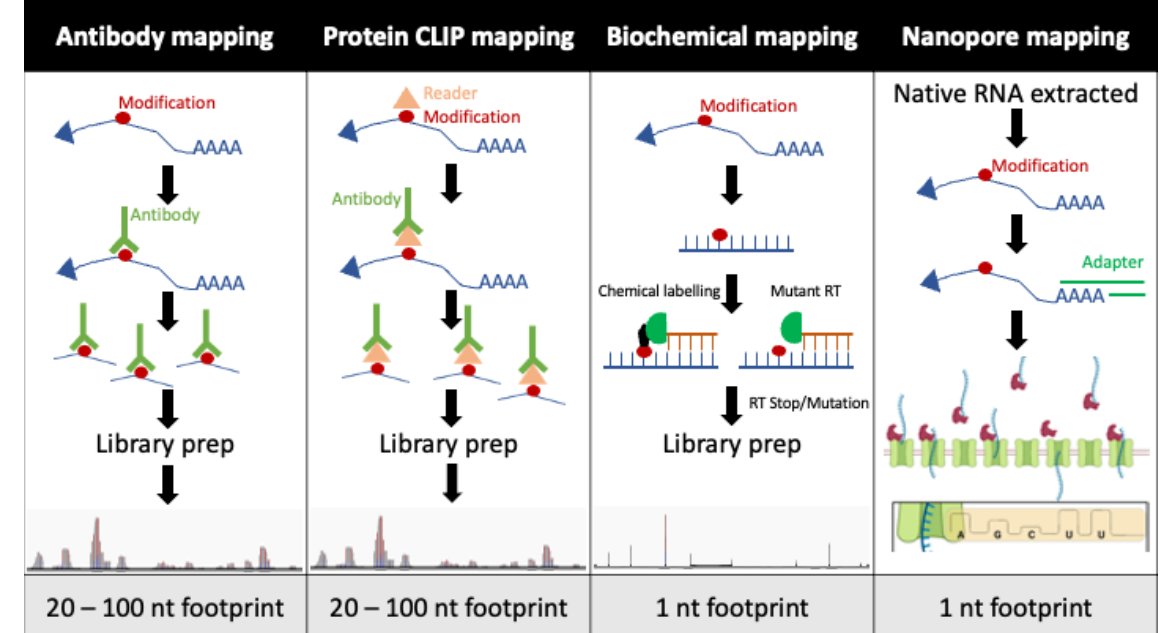
Figure 1. Schematic of the four main methods of mapping RNA modifications. Antibody mapping and protein clip mapping are straightforward techniques involving capture of modified RNA fragments by antibodies before elution and next-generation sequencing, which yields footprints of 20–100 nt. Biochemical mapping generally involves either chemical labelling of a modified residue to block reverse transcription, or a mutant reverse transcriptase that spontaneously stops upon encountering a modified residue. Again, these products undergo next-generation sequencing, but the resultant footprint of these methods is 1 nt. Finally, Nanopore mapping uses a new technique of nucleotide detection by calculating electrical current as the RNA passes through a pore. Each nucleotide alters the electrical current differently, with minor fluctuations also detectable when modified nucleotides are present. This method also results in a 1 nt footprint and is capable of sequencing native RNA.